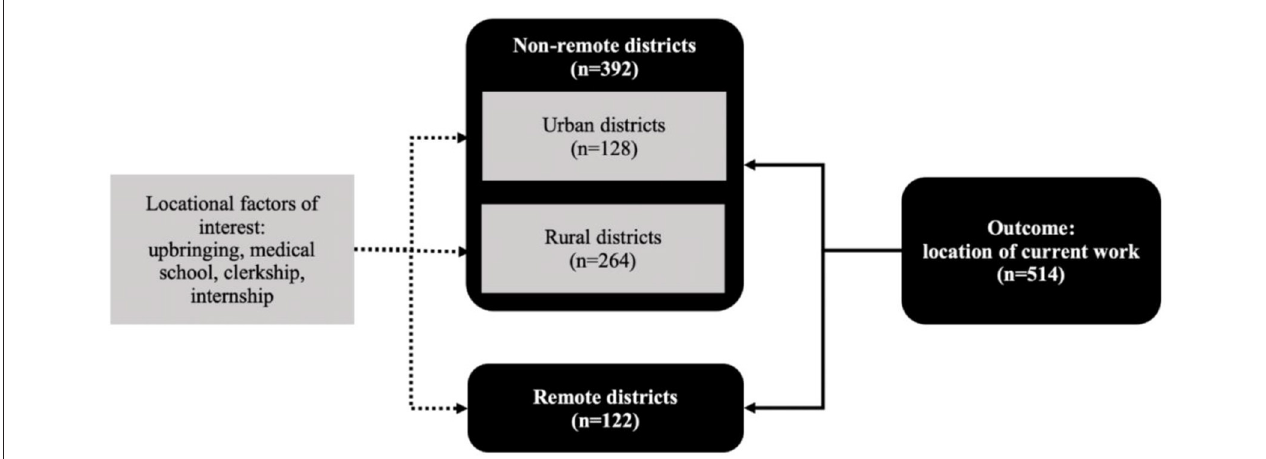
FIGURE 1 | Classifications of outcome and locational factors of interest.